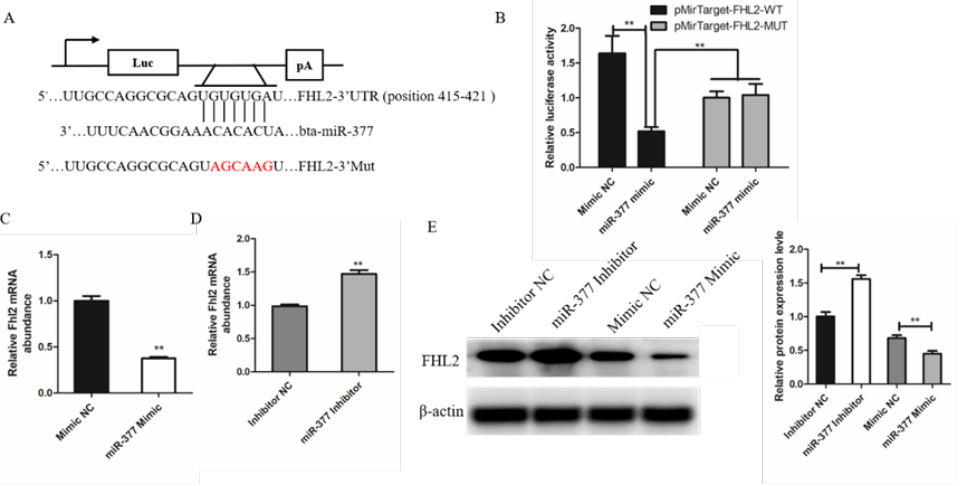
Figure 4. FHL2 is a target gene of miR-337. ( A ) The target gene of miR-37 was predicted by TargetScan. ( B ) The dual-luciferase reporter analysis showing that FHL2 was a direct target of miR-377. ( C ) The mRNA expression levels of FHL2 in Mimic NC or miR-377 Mimic cells by qPCR. ( D ) The mRNA expression levels of FHL2 in Inhibitor NC or miR-377 Inhibitor cells by qPCR. ( E ) Western blot analysis the protein expression levels of FHL2 after transfected with Mimic NC, miR-377 Mimic, Inhibitor NC or miR-377 Inhibitor. Data are expressed as mean ± SEM ( n = 3). ** p < 0.01.